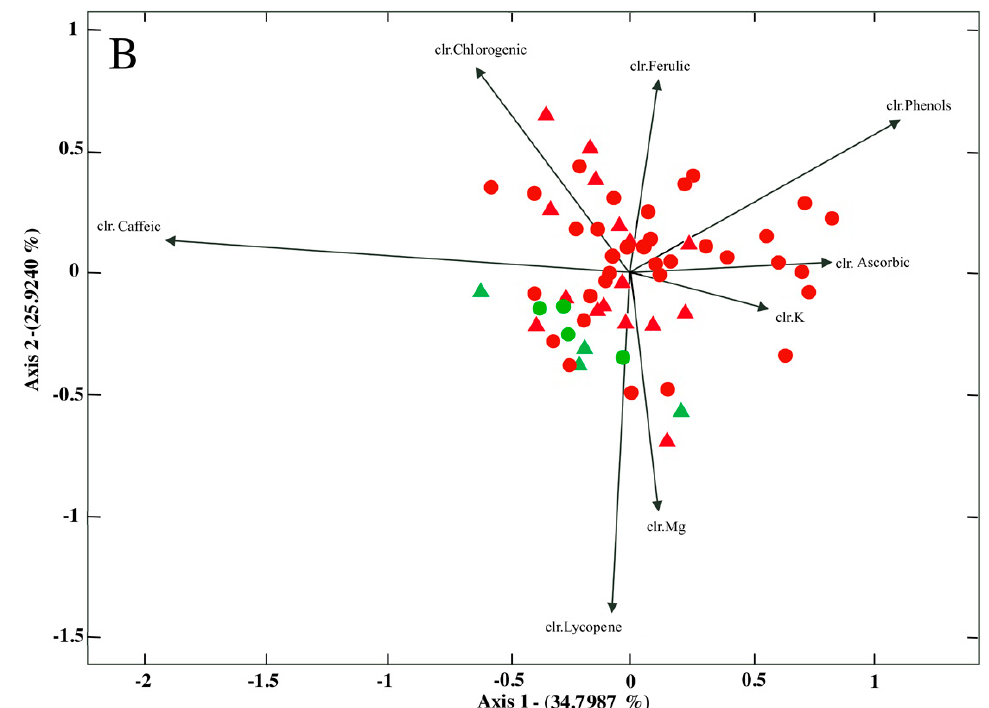
Figure 2. ( A ) Standard HJ-biplot; and ( B ) Compositional HJ-biplot of the chemical composition data. The Mariana tomato cultivar is represented in red; the Dunkan in green. The soil cultivation method is represented with the marker ● ; the no-soil with the marker ▲ .